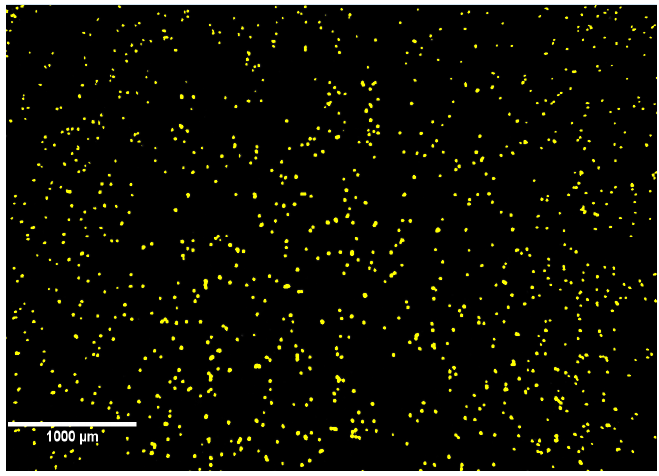
Figure 5. DsRed-labeled hepatocytes captured by cell imaging counting (CIC). Yellow dots represent single hepatocytes.